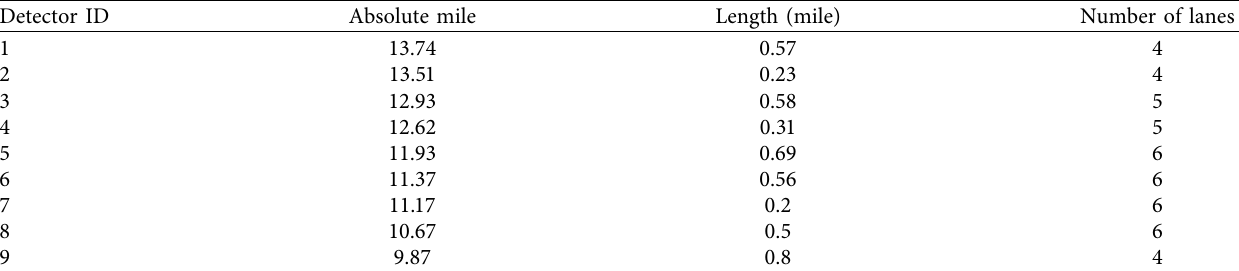
Figure 6: Fundamental diagram in Los Angeles case. (a) fow-density relationship. (b) speed-fow relationship. (c) speed-density relationship. Table 1: Descriptive information about